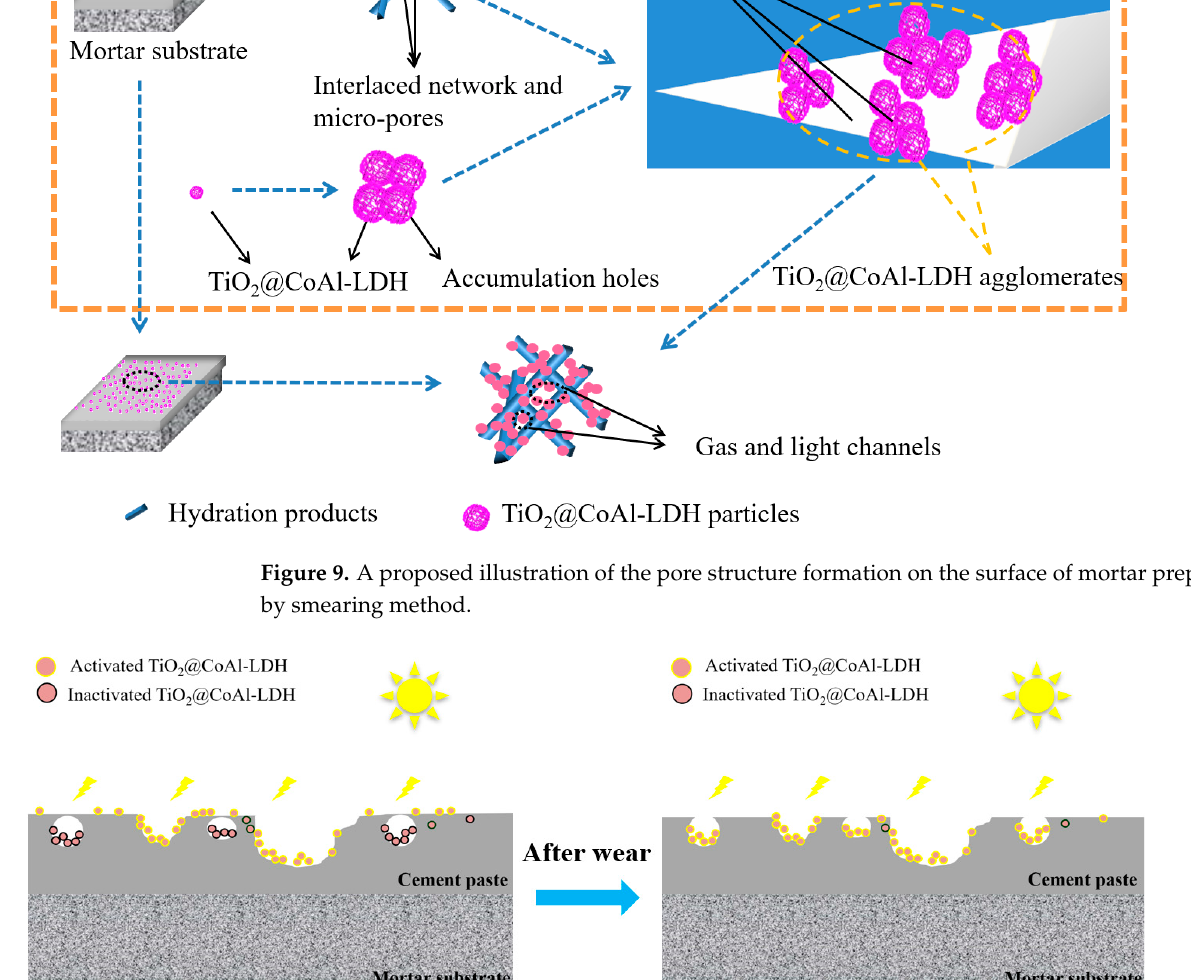
Figure 10. Schematic diagram of the surface of mortar prepared by smearing method before and after wearing.